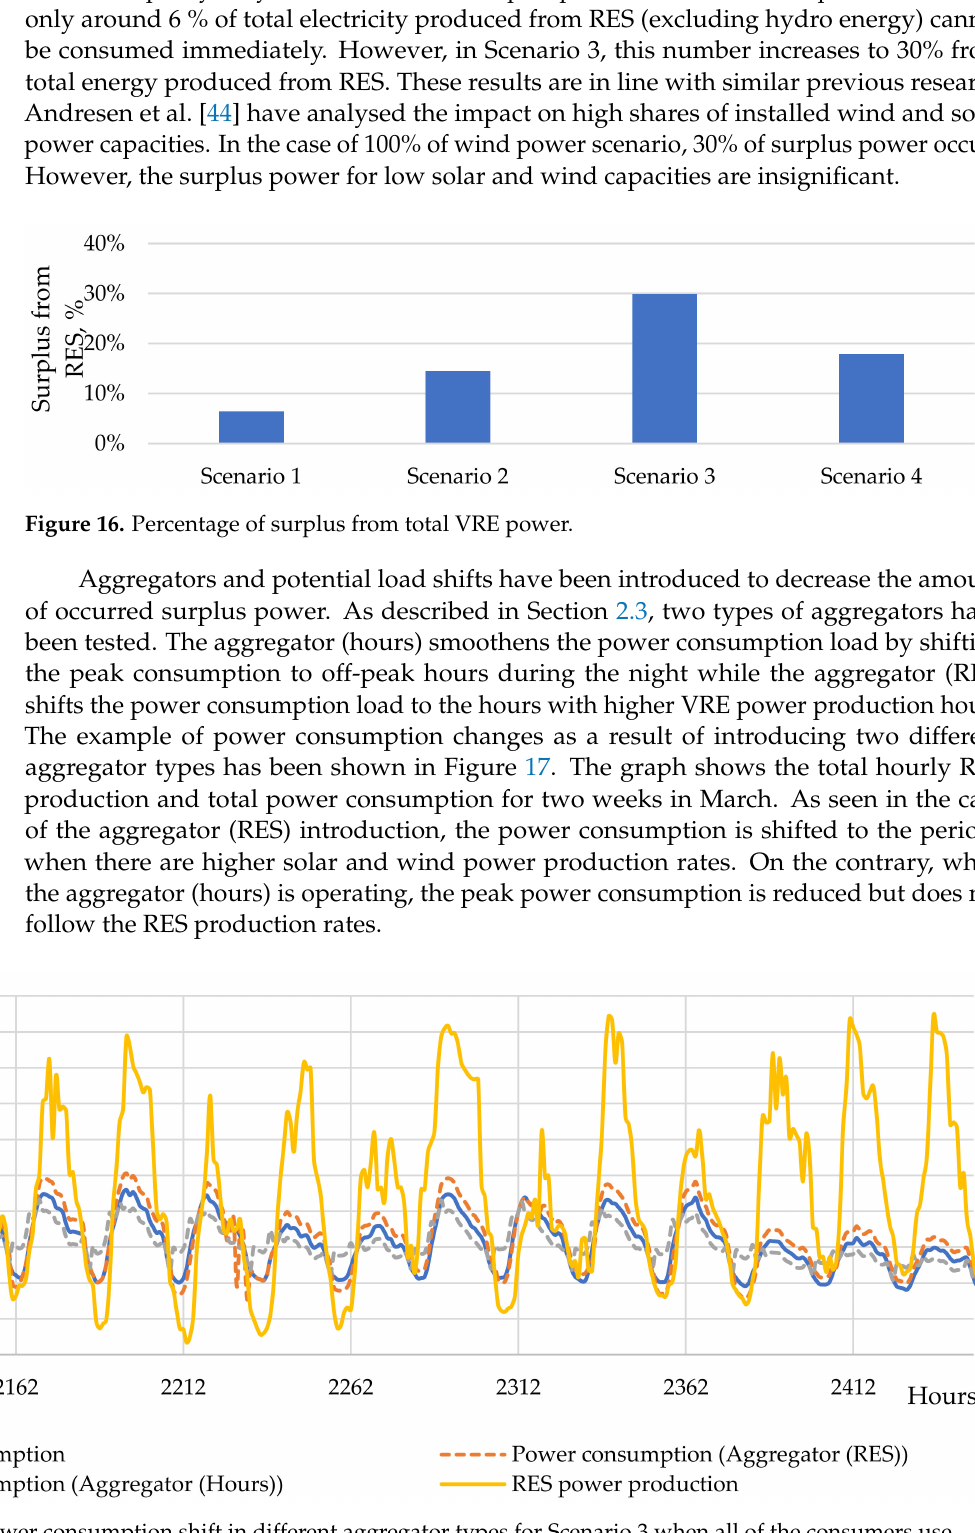
Figure 17. Example of power consumption shift in different aggregator types for Scenario 3 when all of the consumers use aggregator